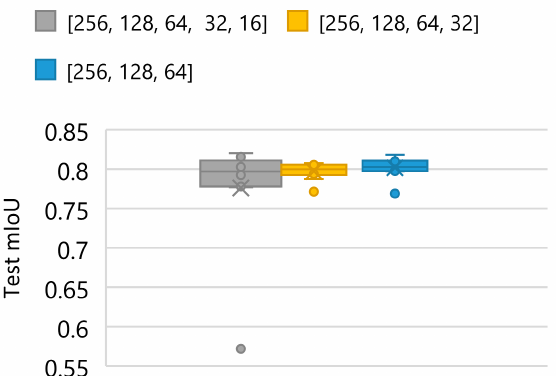
Figure 11. Box and whisker plot of mIoU on test set for different depth of U-Net.